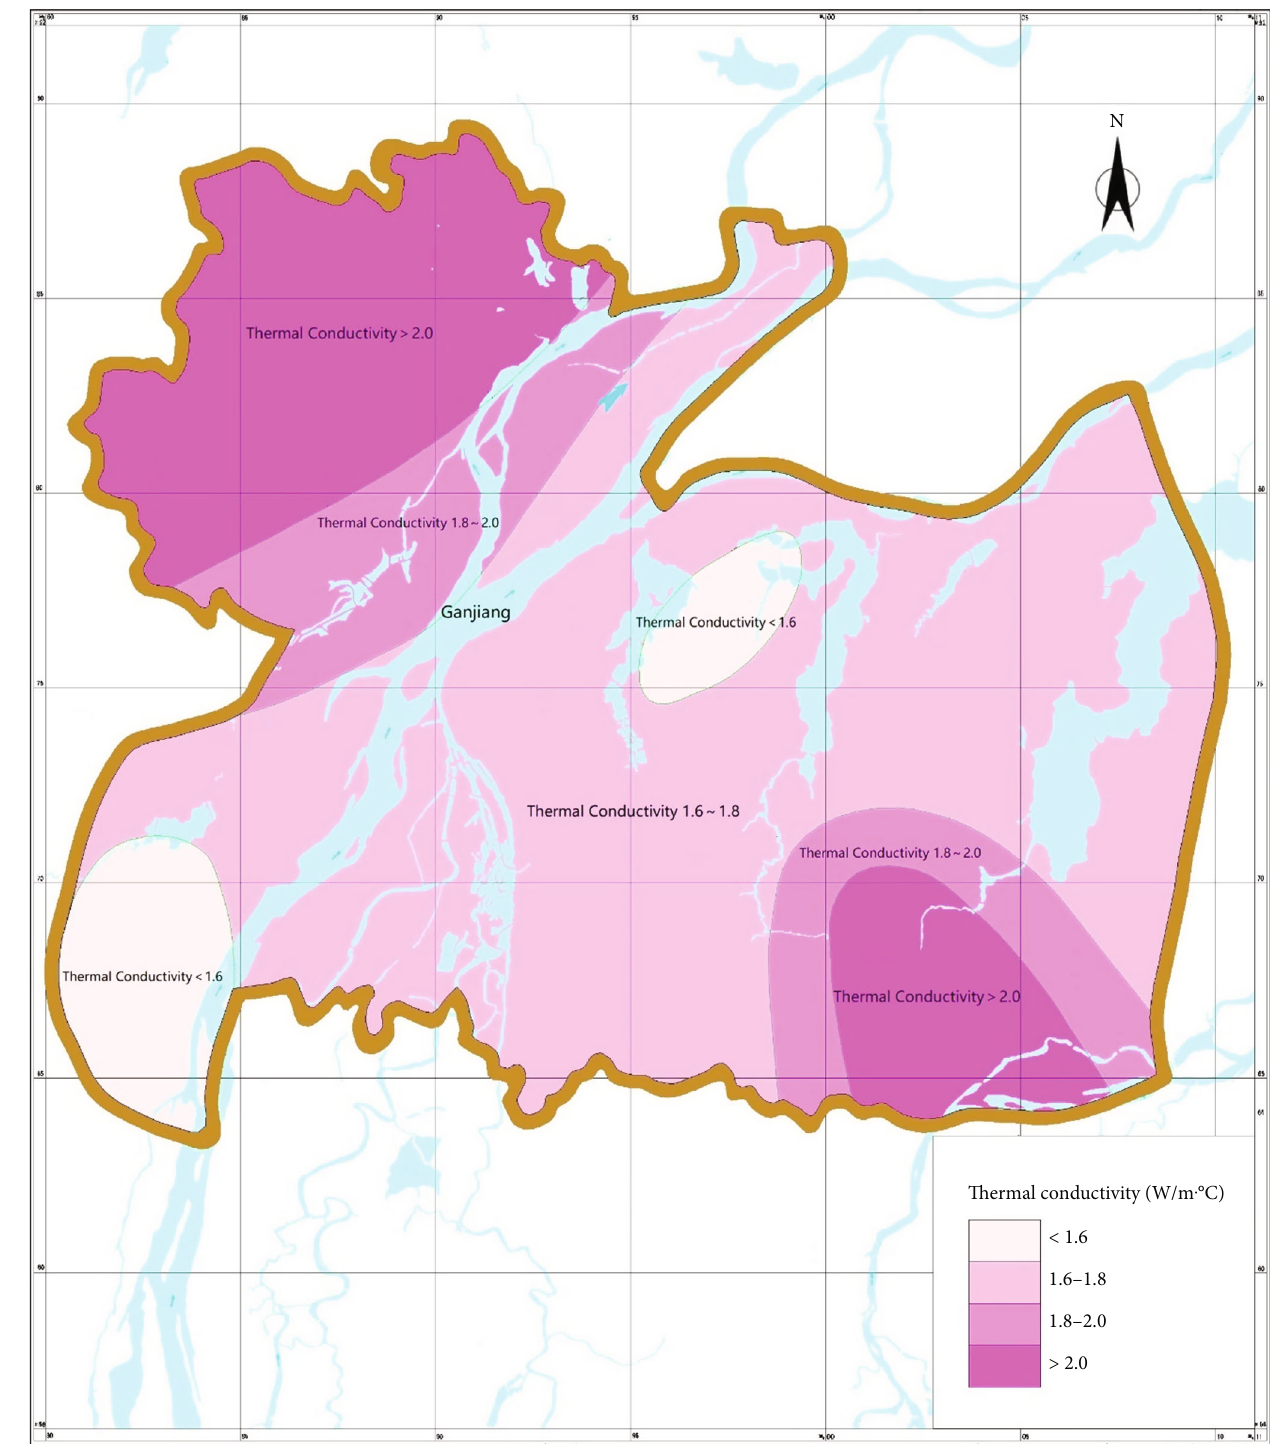
Figure 4: Plan distribution of thermal conductivity of rock and soil